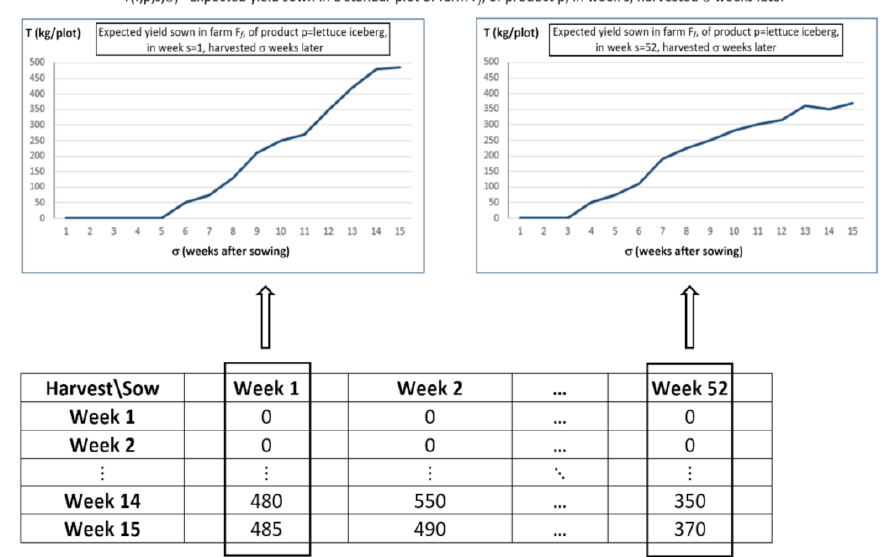
Figure 2. Expected yield T ( f , p , s , σ ) in a standard sized plot in farm F f , for a product p (lettuce Iceberg), sown in week s = 1 . . . 52 and harvested σ weeks later. The graph represents data corresponding to weeks 1 and